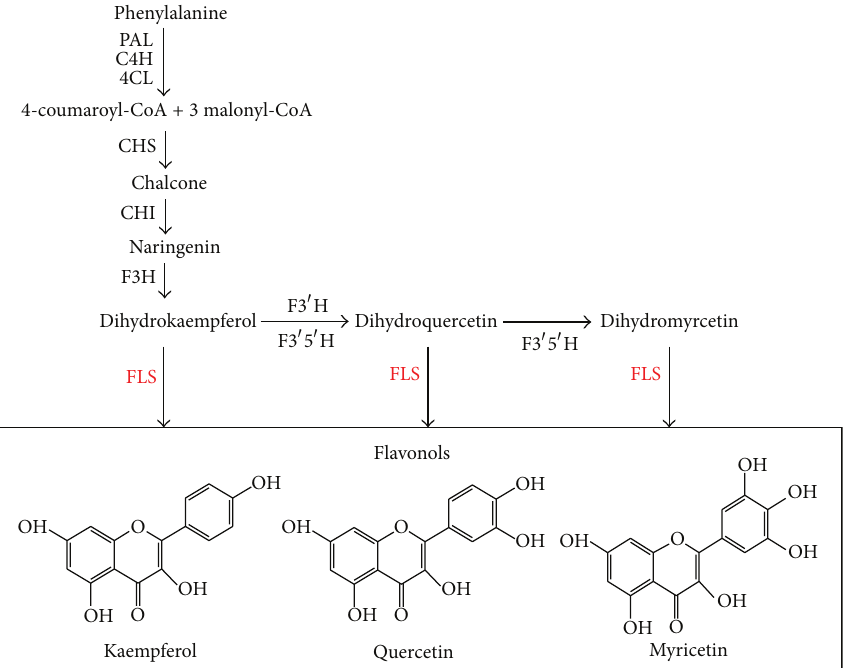
Figure 1: Flavonol biosynthesis in plants (redrawn from [37]). The red letter and black box indicate the enzyme and compound analyzed in this study. PAL, phenylalanine ammonia lyase; C4H, cinnamate 4-hydroxylase; 4CL, 4-coumaroyl CoA ligase; CHS, chalcone synthase; CHI, chalcone isomerase; F3H, flavone 3-hydroxylase; F3 󸀠 H, flavonoid 3 󸀠 -hydroxylase; F3 󸀠 5 󸀠 H, flavonoid 3 󸀠 5 󸀠 -hydroxylase; FLS, flavonol